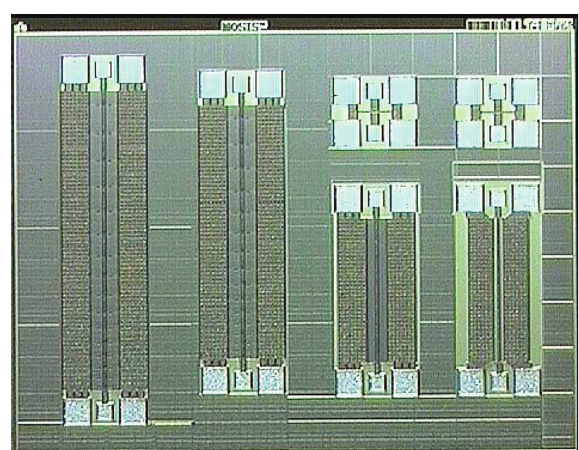
Figure 4: Pulse-compression NLTL chip.